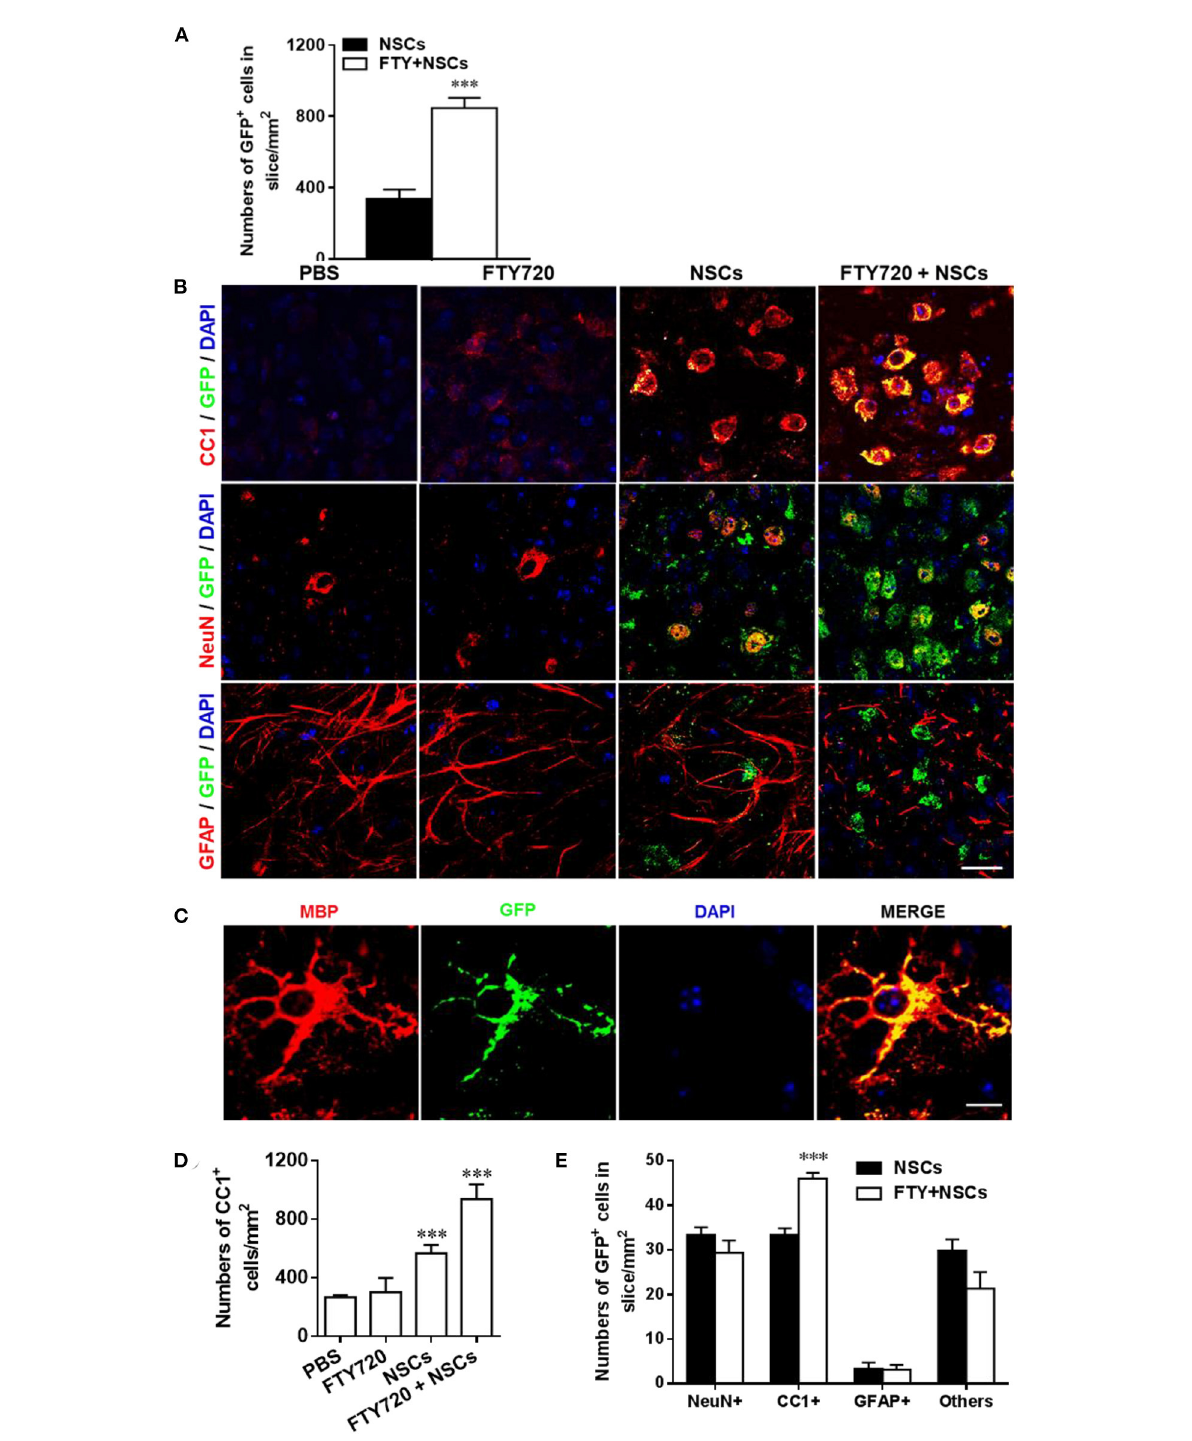
FIGURE2 Impact of FTY720 plus NSC treatment on neural cell lineages in brain slice culture model. Brain slices obtained from newborn (P0-3) C57/Bl6 mouse pups were grown for 3 days in culture, and NSCs (2 µ l, ∼ 5 × 10 4 cells /slice) and/or FTY720 (1nM) were added for the subsequent 7 days; the slices were then fixed and immunostained. (A) Quantitative analysis of the number of transplanted NSCs (GFP + ) in brain slices. (B) Immunofluorescence images of brain slices. Cells co-labeled with GFP and neural specific markers (red) were identified as differentiated cells derived from NSCs (yellow); cells positive only for neural-specific markers (red) were endogenous cells. CC1 + : oligodendrocytes, NeuN + : neurons, GFAP + , astrocytes. Scale bar = 20 µ m. (C) High-magnification confocal images show that GFP (green) was highly colocalized with